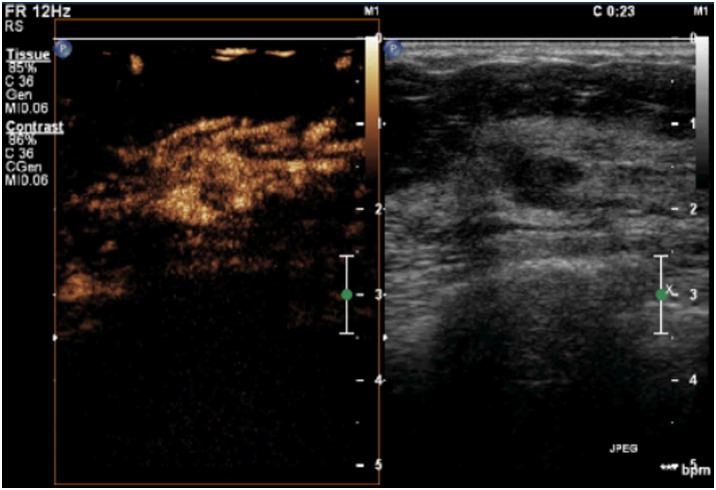
A lesion with a score of 5 by breast contrast-enhanced ultrasound.The lesion is heterogeneously enhanced, with a larger region (compared with that of a 2D image), earlier enhancement, and with/without perfusion defect, particularly with a typical crab claw-like enhancement and an unclear borderline.